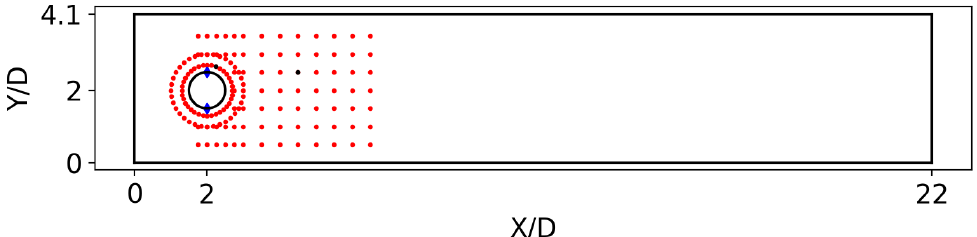
Figure 3. Schematic representation of the computational domain, where the red dots correspond to the location of the probes. The position of two probes is remarked as black dots for further analysis in Section